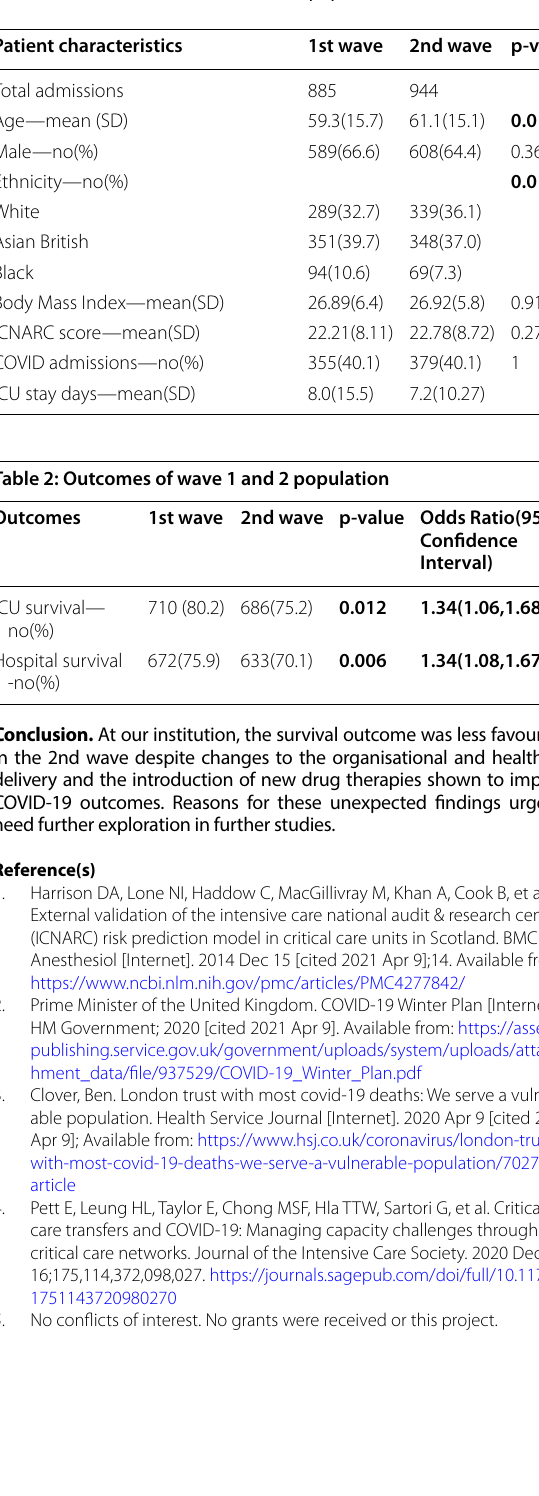
Table 1. Characteristics of wave 1 and 2 population